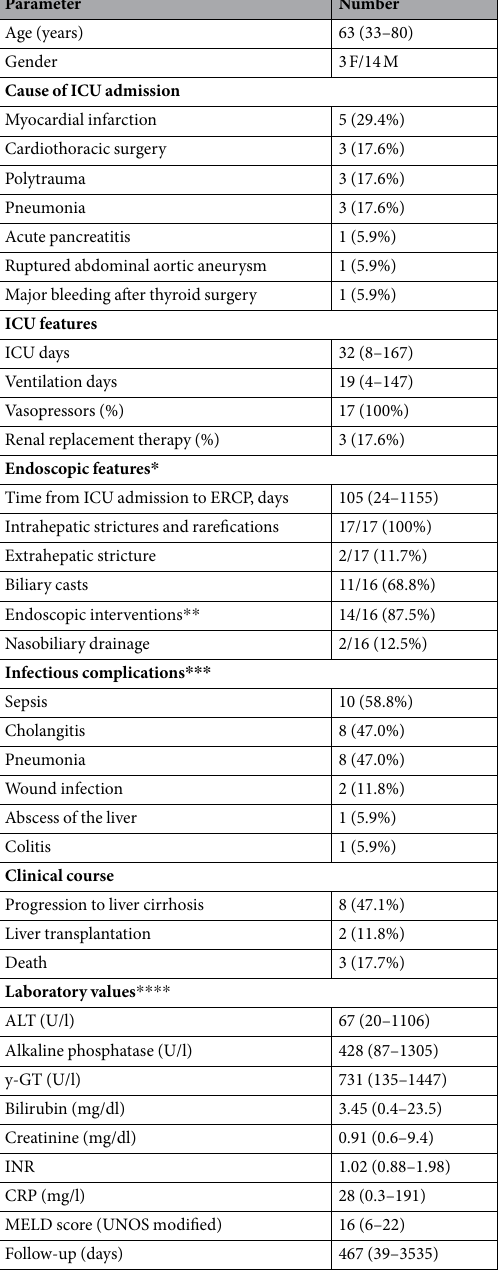
Table 1. Clinical, endoscopic and laboratory characteristics of Cohort 1 comprising 17 patients with SC-CIP. Values are given as medians and ranges. Abbreviations: ALT, alanine aminotransferase; CRP, C-reactive protein; ERCP, endoscopic retrograde cholangiopancreaticography; F, female; γ -GT, gamma-glutamyl-transferase; ICU, intensive care unit; INR, international normalized ratio; M, male; MELD, model of end-stage liver disease; SC-CIP, sclerosing cholangitis in critically ill patients. * In 16 of the 17 patients with SC-CIP in cohort 1, cholangiography was obtained by endoscopic retrograde cholangiography procedure, and in one patient magnet resonance cholangiography was performed only. ** Endoscopic interventions include biliary cast extraction, ballon dilation or intermittent stent placement. *** Patients may have had more than one infectious complication. **** Values from the day of the first